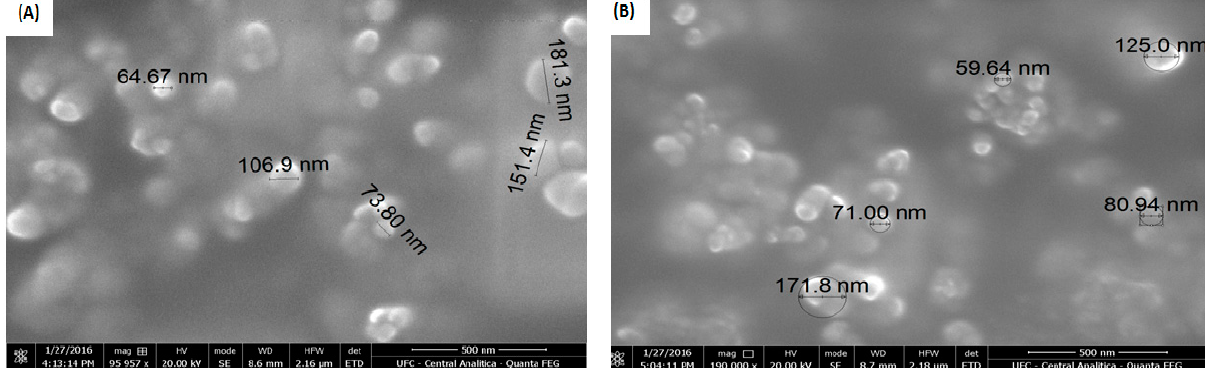
Figure 3. Spectra were obtained in the infrared region for samples of Chitosan, Cardanol* (CHI/TPP/ALG, and CHI/TP/AG).